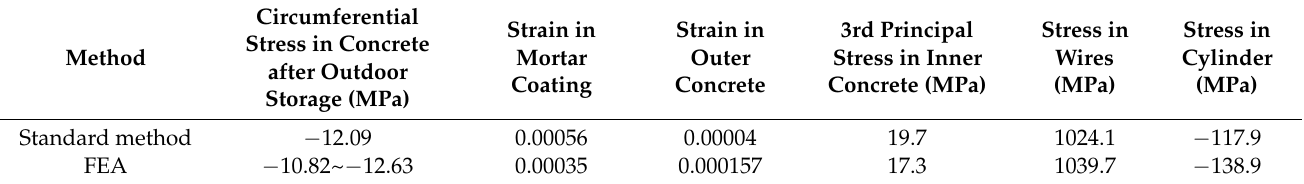
Table 6. Main analysis results of pipe No.1 before wires broke.